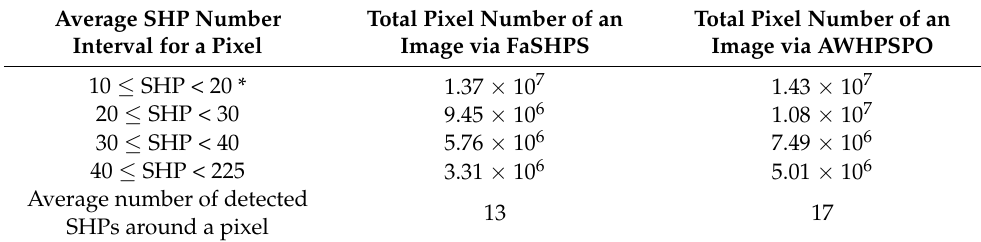
Table 1. Comparison of the number of SHPs (statistically homogeneous points).